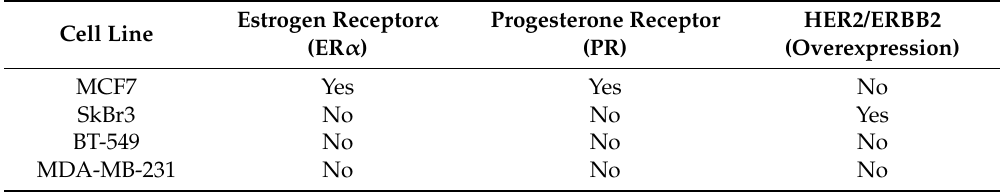
Table 4. Expression status of ER α , PR, and HER2/ERBB2 in four breast cancer cell lines